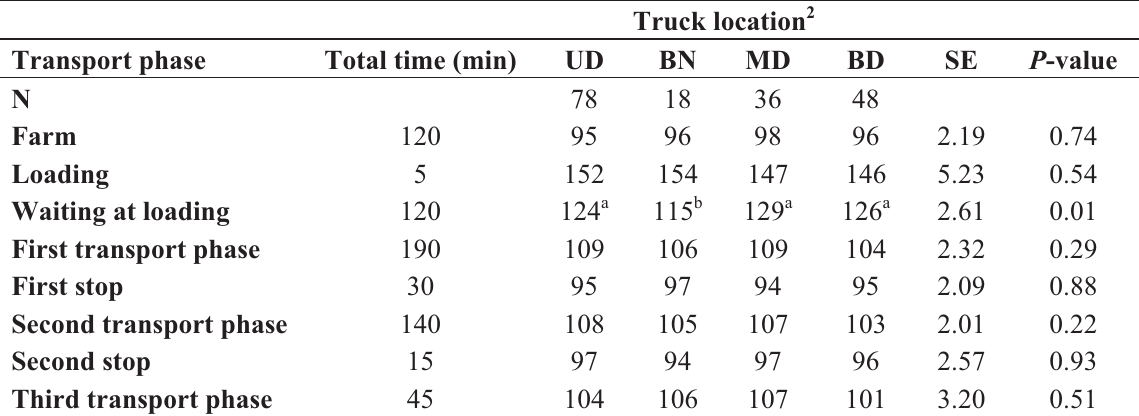
Table 1. Effects of animal location during transport on the pot-belly (PB) trailer on heart rate 1 average values in summer.